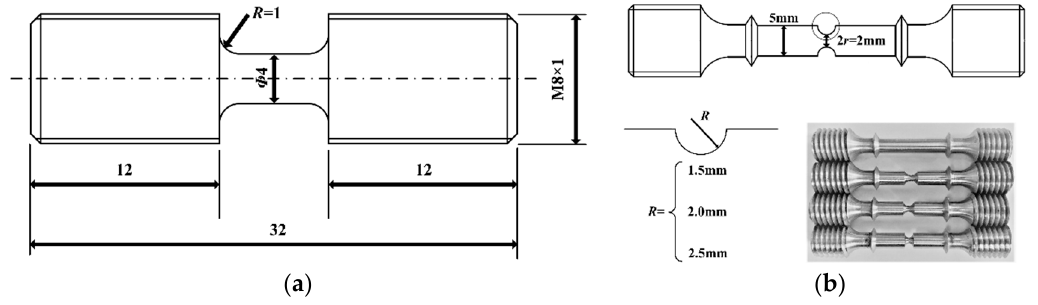
Figure 1. ( a ) Specimens for dynamic tensile experiments; and ( b ) specimens with different notches radii for quasi-static tensile experiments. radii for quasi-static tensile